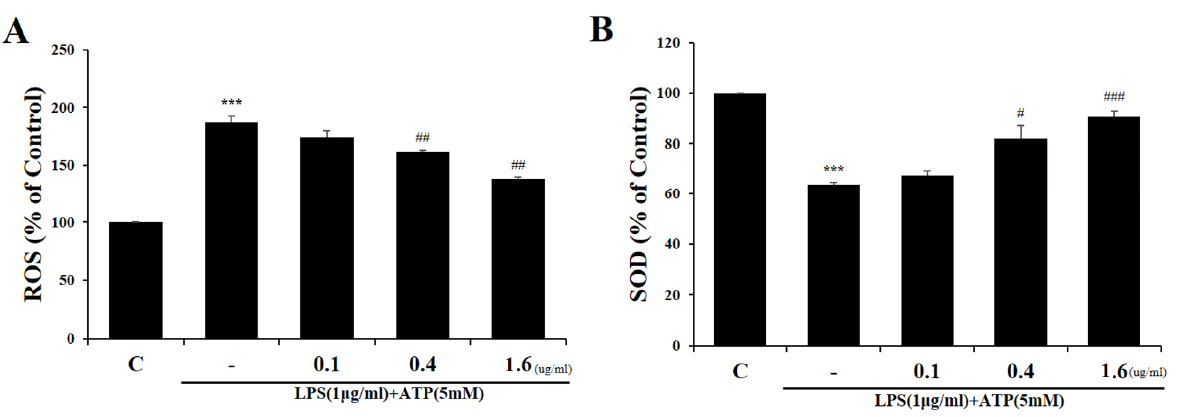
Figure 3. Effect of T β 4 on ROS generation and SOD activity in LPS and ATP ‐ induced LX ‐ 2 cells. LX ‐ 2 cells were pretreated with T β 4 (0.1, 0.4, and 1.6 μ g/mL) for 1 h, followed by NLRP3 inflammasome induction using LPS (1 μ g/mL) for 4 h and ATP (5 mM) for 30 min. ( A ) ROS generation was evaluated by an ROS assay kit. ( B ) SOD expression was measured by ELISA in the cell lysates. Data are presented as mean ± SEM (n = 3). *** p < 0.005 compared with the C. # p < 0.05 compared with the LPS and ATP ‐ treated group. ## p < 0.01 compared with the LPS and ATP ‐ treated group. ### p < 0.001 compared with the LPS and ATP ‐ treated group.